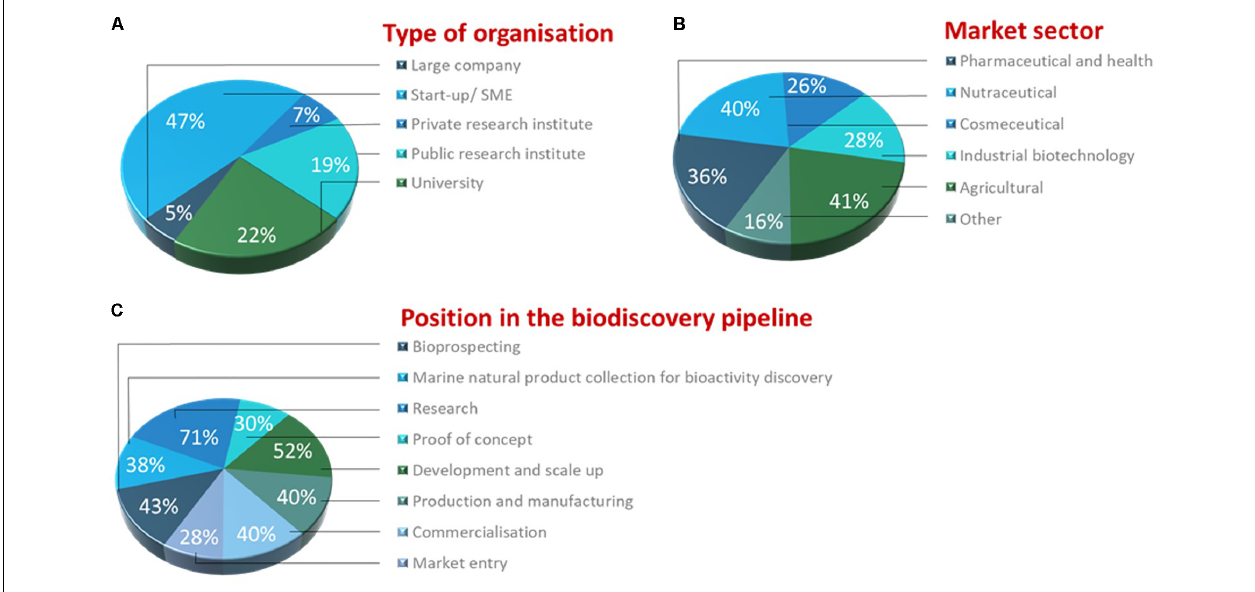
FIGURE 4 | (A) Proportion of different organization types represented by survey respondents. (B) Proportion of different target end markets represented by survey respondents (some organizations were linked to more than one end market sector, therefore percentages total more than 100%). (C) Proportion of different phases within marine bioresource value chain represented by survey respondents (some organizations linked to more than one position in the pipeline, therefore percentages total more than 100%).